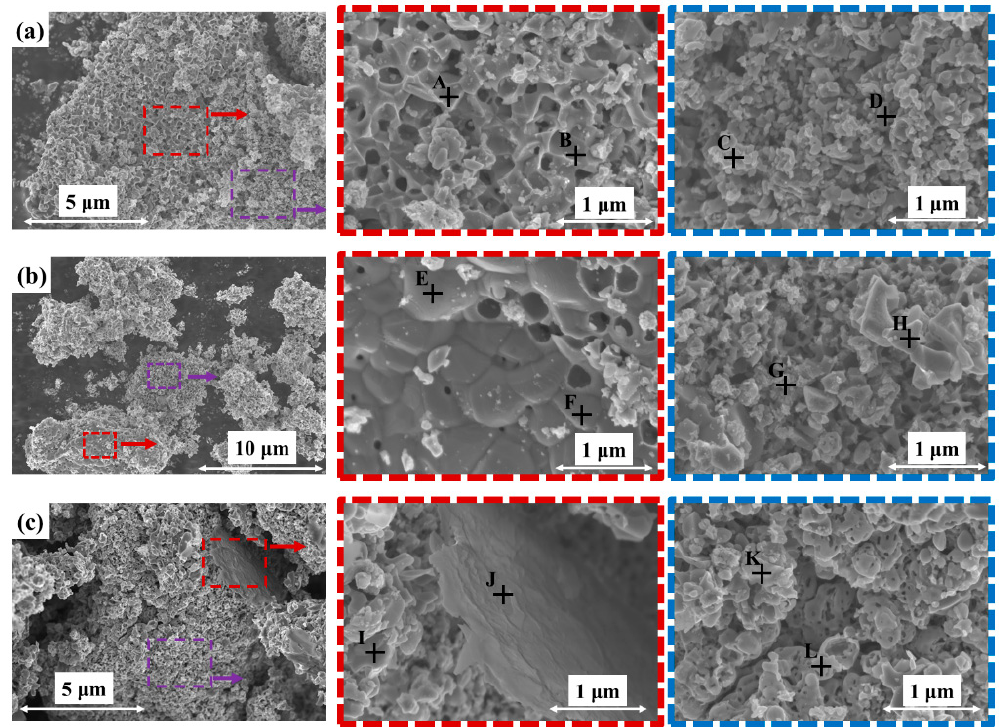
Figure 5. SEM photos for SHS products(leached) of the Mg-TiO 2 system at different sample preparation pressures: ( a )25;( b ) 75;( c ) 150 MPa. pressures: ( a ) 25; ( b ) 75; ( c ) 150